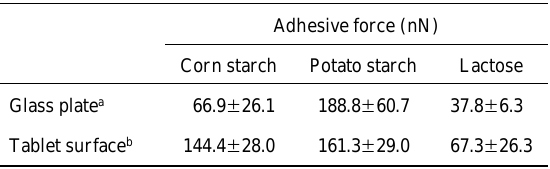
a Each value represents the mean (cid:5) S.D. (n (cid:2) 5). b Each value represents the mean (cid:5) S.D. (n (cid:2) 8).